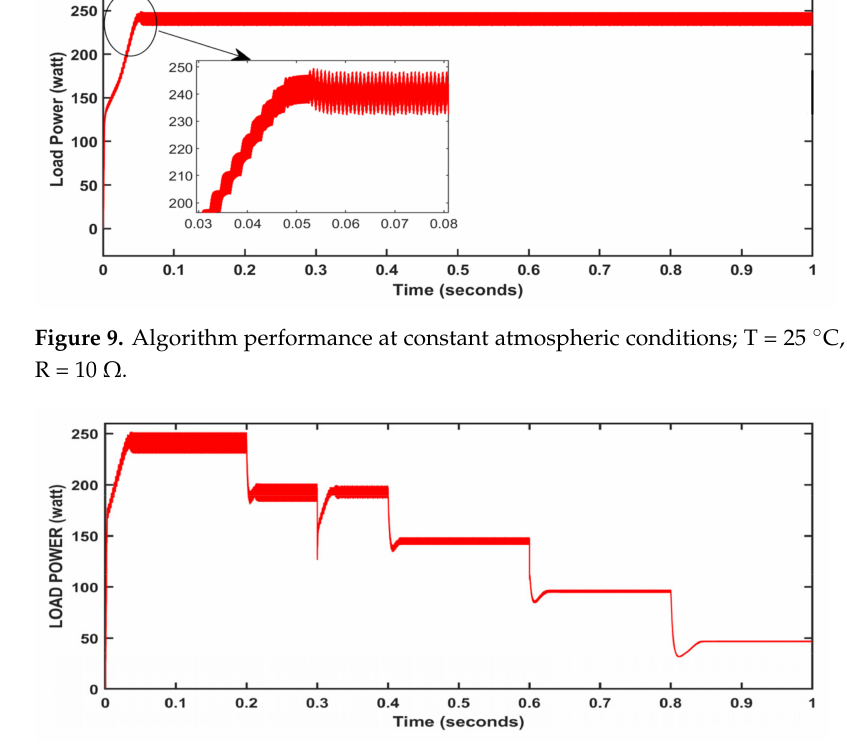
Figure 10. Algorithm performance at variable irradiations and variable loads; T = 25 ◦